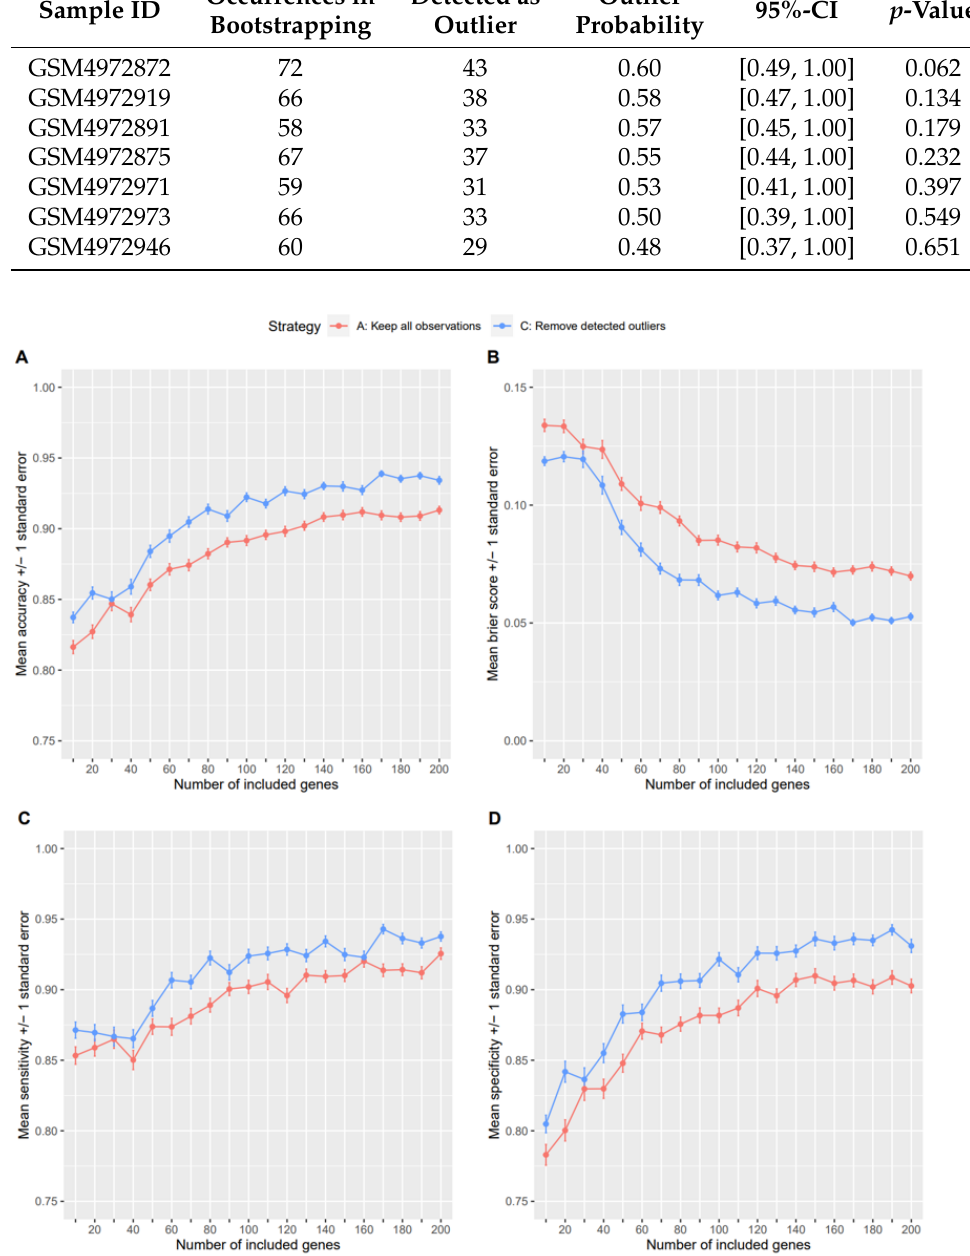
Figure 7. Performance measures for different outlier handling strategies for the SARS-CoV-2 dataset. The plots show mean values with bars representing standard errors for accuracy ( A ), Brier score ( B ), sensitivity ( C ), and specificity ( D ), respectively, when using a SVM for classification and for different numbers of most differentially expressed genes to be included in each of the